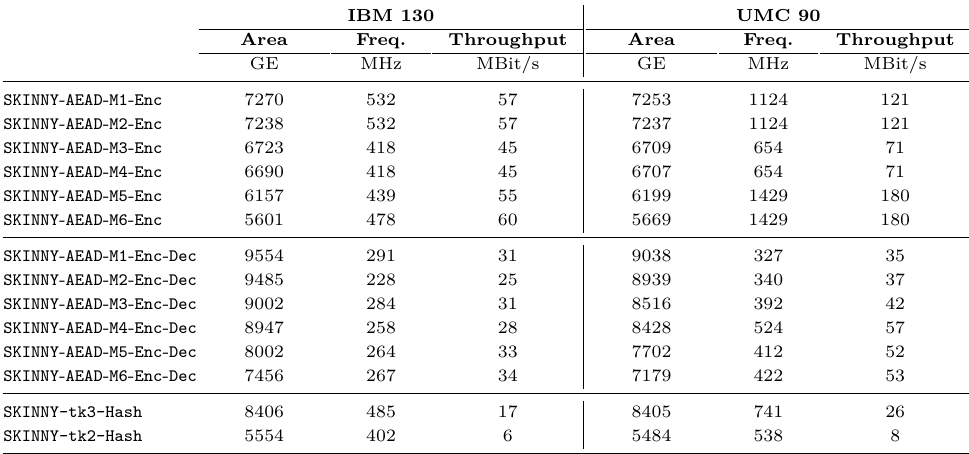
Table 11: Unprotected, byte-serial ASIC implementations of SKINNY-AEAD / SKINNY-Hash . IBM 130 UMC 90 Area Freq. Area Freq.